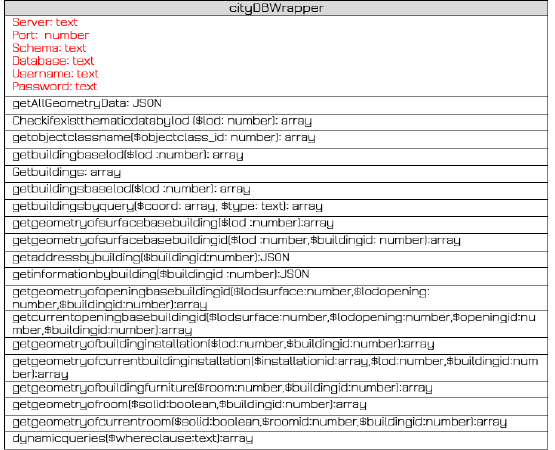
Figure 4. Structure of cityDBWrapper Class